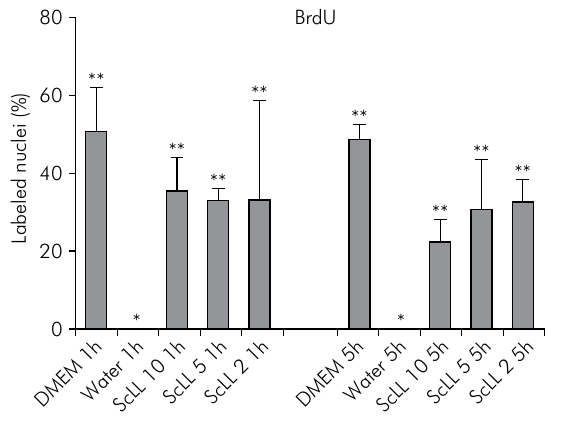
Figure 4. Release of IL-10 in HGFs examined by Elisa at 1 and 5 h. Statistical significance was determined using one-way ANOVA and Dunnet’s test. #p<0.05 compared between the experimental groups. *p < 0.05 compared with positive control (DMEM). **p < 0.05 compared with negative control (tap